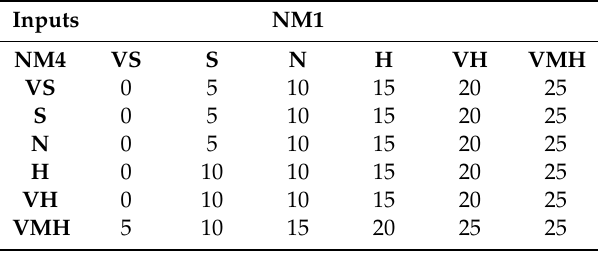
Table 2. Rules for the proposed fuzzy logic (FL) system.